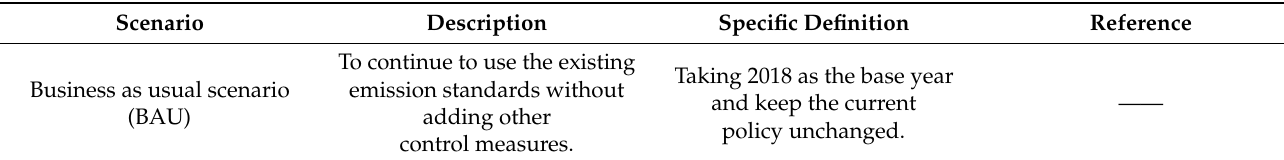
Table 1. The description of reduction scenarios for